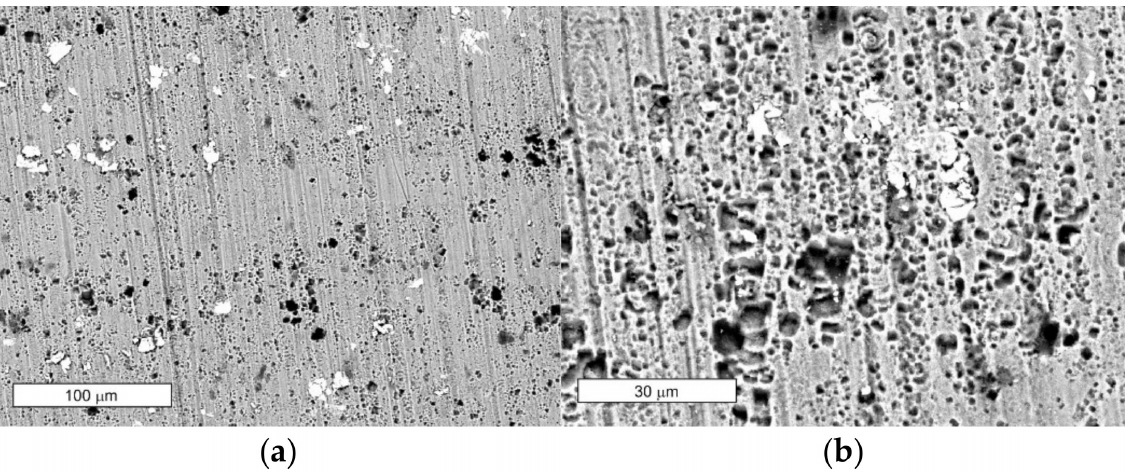
Figure 19. Corrosion changes observed after electrochemical tests on the sample surface in RRA state ( a , b ), SEM.